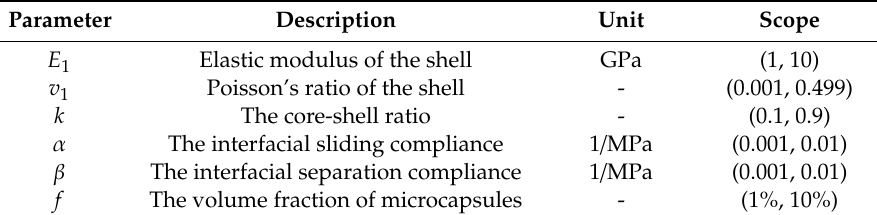
Table 1. Parameters used for the sensitivity analysis.